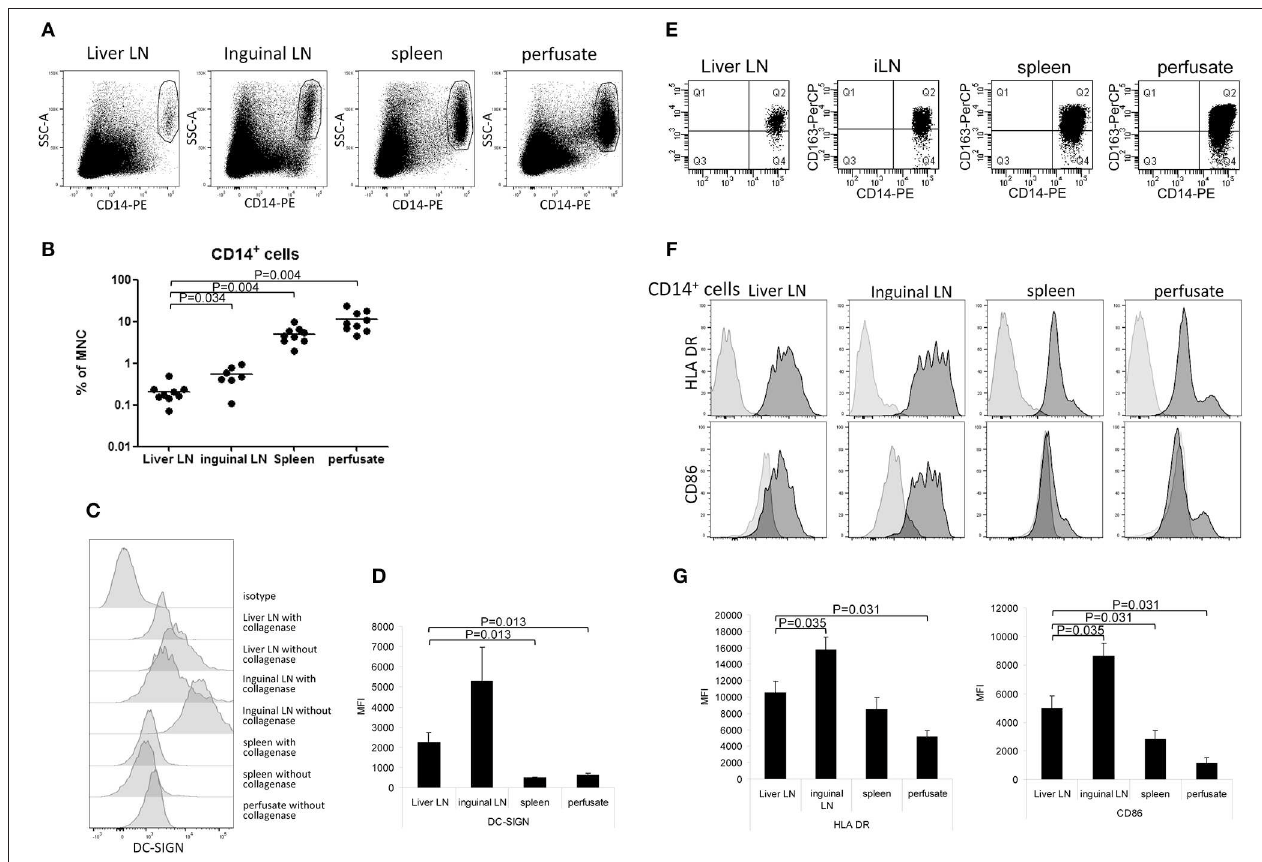
FIGURE 5 | Relative CD14 + cell numbers and their activation status in hepatic and inguinal lymph nodes, spleen, and liver. (A) CD14 + cells were determined within vital CD45 − MNC. Representative dot plots are shown. (B) A summary of the percentages of CD14 + cells within vital CD45 − MNC isolated from the different tissues. Data from individual tissues are depicted as dots and lines indicate mean values on a log-scale. (C) DC-SIGN-expression on CD14 + cells that were isolated from tissues with collagenase or without collagenase treatment. Tissues were divided into two parts, and after cutting into small pieces, one part was treated with collagenase and the other part not. After that, single cell suspensions were made from both parts. (D) Summary showing DC-SIGN expression levels on CD14 + cells from liver lymph nodes ( n = 6) and inguinal lymph nodes ( n = 7), spleen ( n = 6), and liver ( n = 6). Except for liver, MNC were isolated from the tissues using collagenase. Data are depicted as means with SEM. (E) CD163 expression on CD14 + cells in MNC from liver LN, inguinal LN, spleen and liver perfusate. (F) Histograms showing HLA-DR and CD86 expression on CD14 + cells in the different tissues. Light gray histograms are isotype control stains. (G) Summary of HLA-DR and CD86 expression levels on CD14 + cells in liver lymph nodes ( n = 6), inguinal lymph nodes ( n = 7), spleen ( n = 6), and liver ( n = 6). Data are depicted as means with